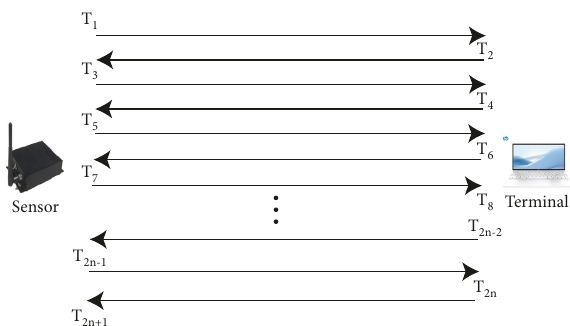
Figure 3: Actual sensor and terminal timestamp